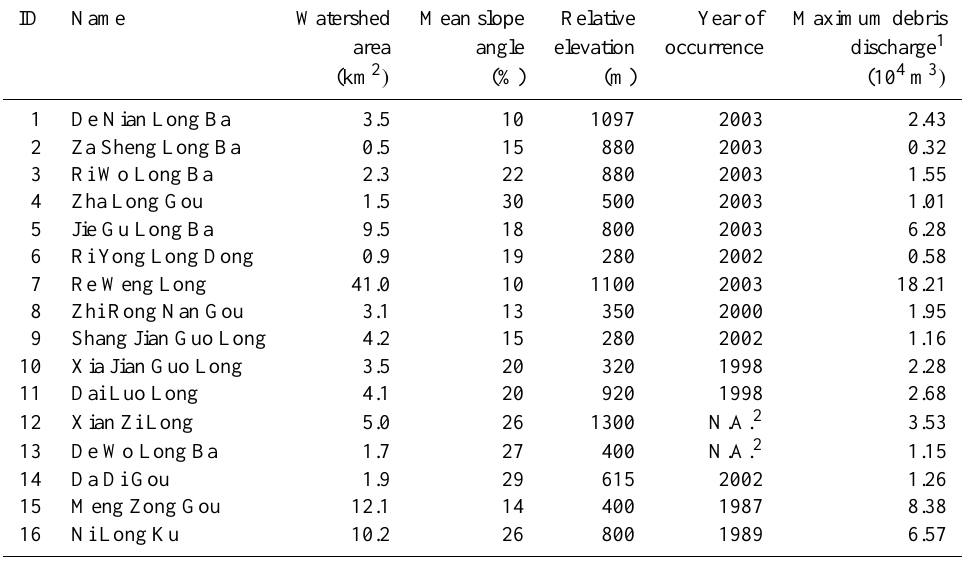
Table 1. Gullies surrounding Jiegu township in which debris flow events have occurred at least once and their corresponding historical events. ID